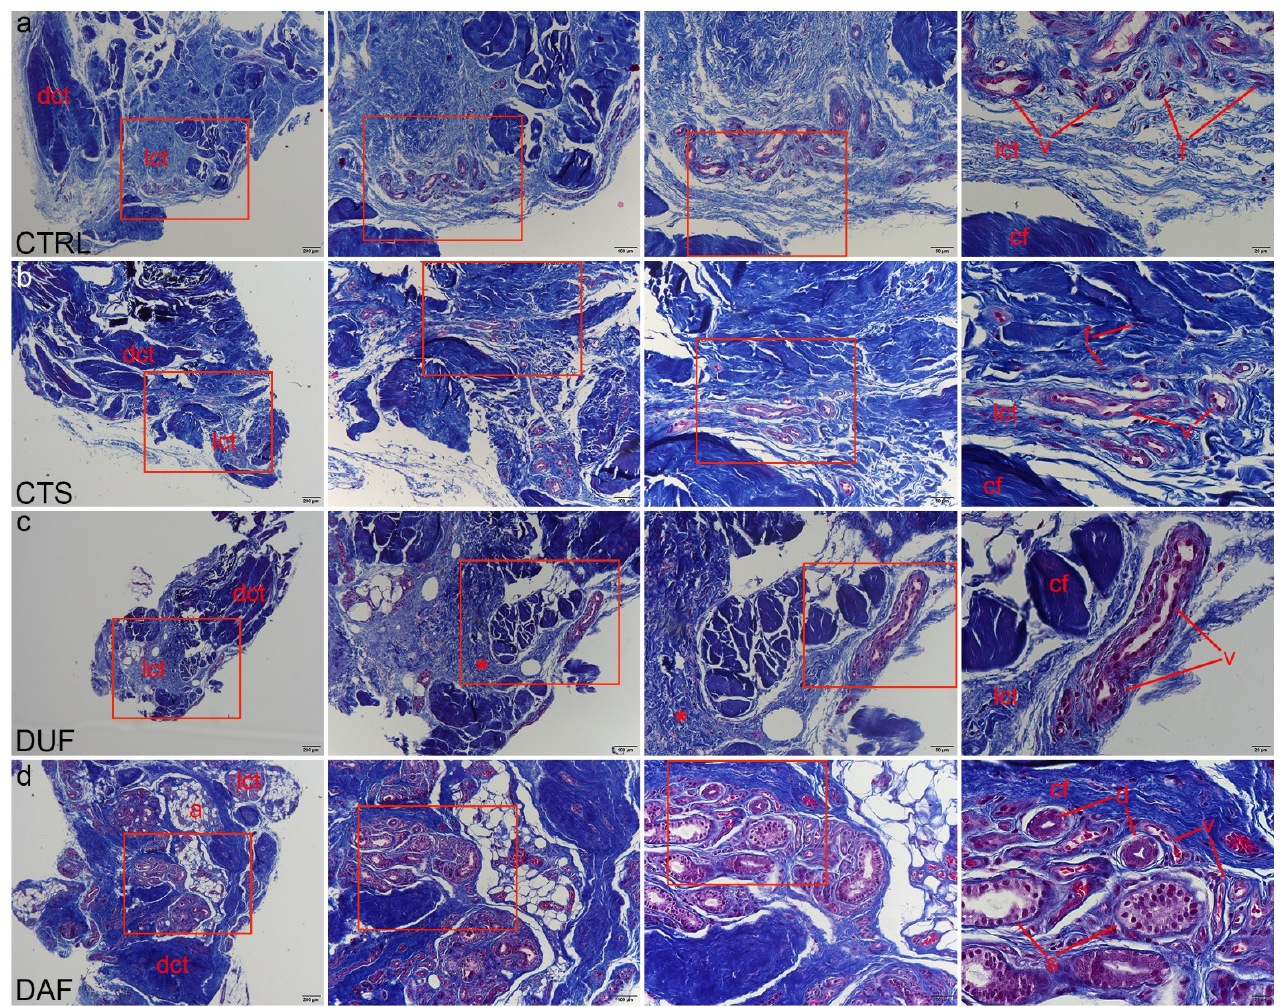
Figure 2. Mallory trichrome staining of connective tissues of CTS and DD patients. Rectangles mark the area presented at a higher magnification in the following image. Healthy palmar fascia samples show dark blue staining of collagen fibers (cf) in dense connective tissue (dct), with lighter blue areas of loose connective tissue (lct) containing blood vessels (v) and fibroblasts (f) ( a ); the flexor retinaculum of CTS patients contains more areas of darker staining dense connective tissue (dct) with collagen fiber bundles (cf), while in areas of loose connective tissue (lct), blood vessels (v) are observed ( b ); the clinically unaffected palmar fascia of DD patients (DUF) also contains areas of dense connective tissue (dct) made up of mostly collagen fibers (cf) and areas of loose connective tissue (lct) with blood vessels (v). Some regions of loose connective tissue display darker blue staining (asterisks), signifying denser collagen packing ( c ); in samples of affected palmar fascia of DD patients (DAF), dark blue staining of collagen fibers (cf) characterizes areas of dense (dct) and loose connective tissue (lct), also surrounding blood vessels (v), adipocytes (a), and secretory parts (s) and ducts (d) of sweat glands ( d ); 1st column, 40× magnification, scale bar 200 µm ; 2nd column, 100× magnification, scale bar 100 µm; 3rd column, 200× magnification, scale bar 50 µm; 4th column, 400× magnification, scale bar 20 µm.